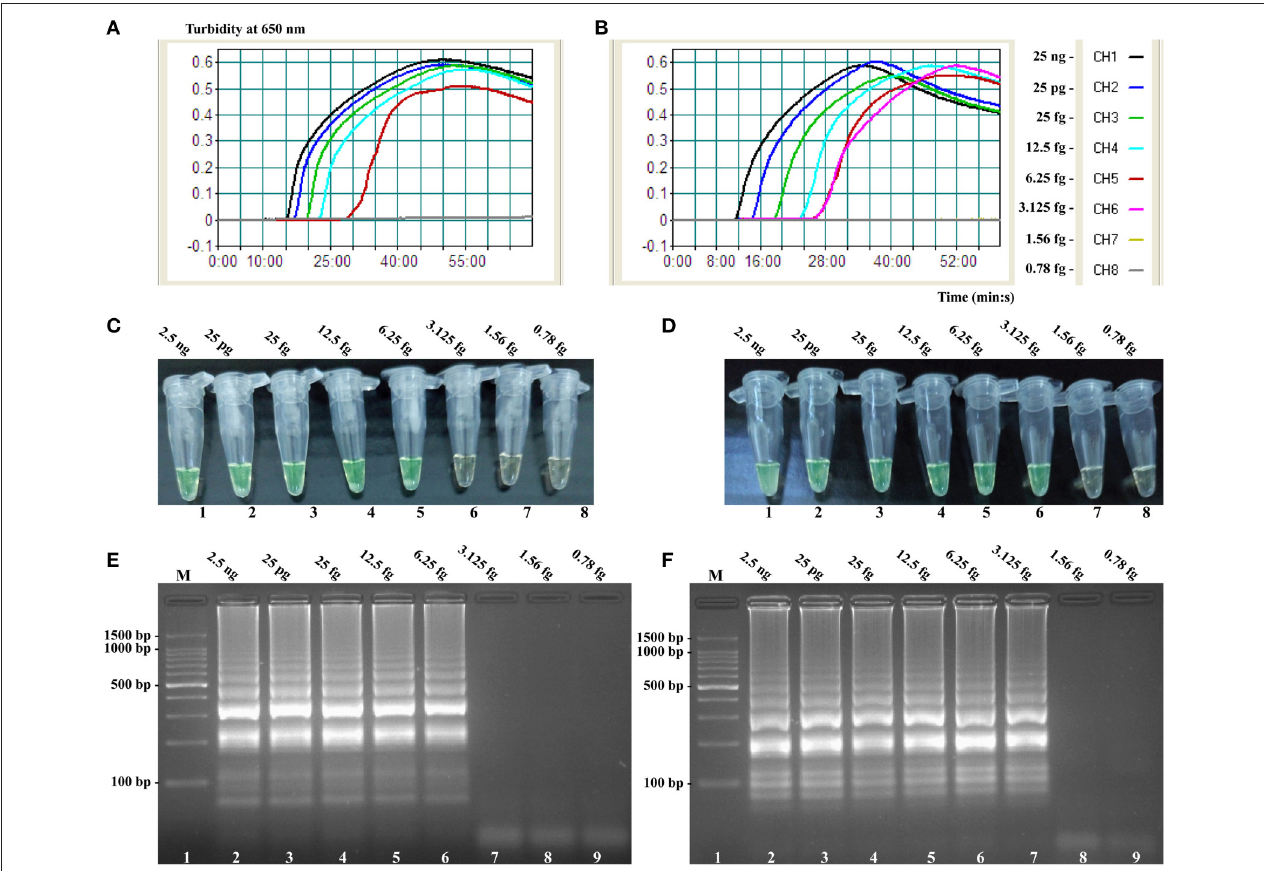
FIGURE 7 | Sensitivity of the invA - and ipaH -MCDA techniques using serially genomic DNA with Salmonella strains and Shigella strains as templates. Sensitivity of invA -MCDA for Salmonella (A) and ipaH -MCDA for Shigella (B) detection was monitored by real-time measurement of turbidity and the corresponding curves of concentrations of genomic DNA were marked in the figure. The LoD of invA -MCDA assay was 6.25 fg per vessel, and the ipaH -MCDA for 3.125 fg per reaction. Sensitivity of invA -MCDA for Salmonella (C) and ipaH -MCDA for Shigella (D) detection was monitored by FD reagent, and a color shift of positive reactions in Salmonella - and Shigella -MCDA tubes from light gray to green were directly seen with naked eyes. Moreover, the sensitivity of invA -MCDA for Salmonella (E) and ipaH -MCDA for Shigella (F) detection was analyzed by 2% agarose gel electrophoresis, and the positive results were seen as a ladder-like pattern on 2% agarose gel electrophoresis analysis. Lane 1, DL 100-bp DNA